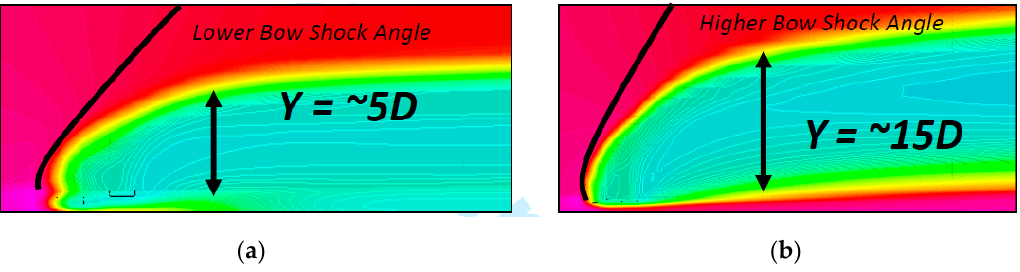
Figure 18. Bow shock extent in terms of flow field density (kg/m 3 ). ( a ) Staggered; ( b ) Aligned.